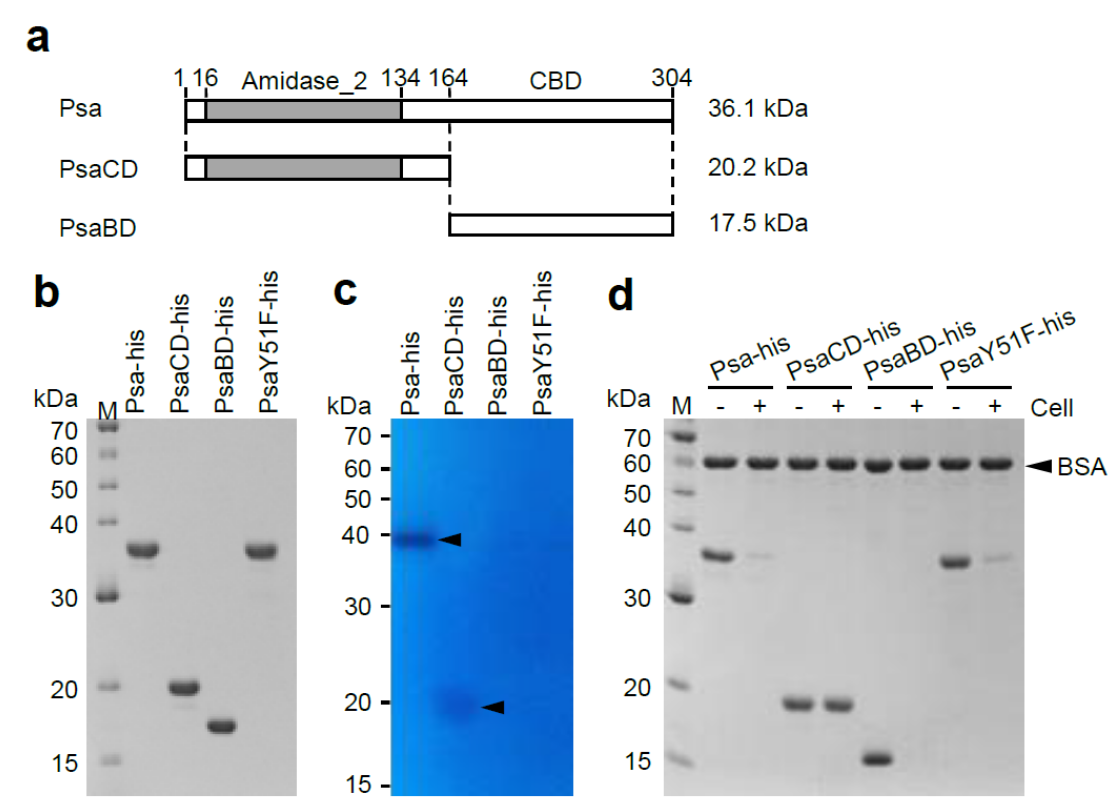
Figure 2. SDS-PAGE analysis, zymography analysis, and binding analysis of Psa-his, PsaCD-his, PsaBD-his, and PsaY51F- his. ( a ) Schematic diagrams of Psa, PsaCD, and PsaBD are shown Psa has an N-terminal catalytic domain (CD) of the amidase_2 family (indicated by gray bar) and a novel C-terminal cell wall-binding domain (CBD). These proteins were expressed and purified with a histidine-tag (MNHKVHHHHHH) fused to the N-terminus. The molecular weights of each histidine-tagged protein are shown on the right of the corresponding horizontal bar. ( b ) Purified Psa-his, PsaCD-his, PsaBD- his, and PsaY51F-his (1 µ g each) were subjected to 12.5% SDS-polyacrylamide gel electrophoresis. The gel was stained with Coomassie blue R. ( c ) Zymography analysis was carried out according to the Materials and Methods. Purified Psa-his (0.5 µ g), PsaCD-his (2.0 µ g), PsaBD-his(2.0 µ g), and PsaY51F-his (0.5 µ g) were electrophoresed in a 12.5% SDS-polyacrylamide gel containing 20 OD 600 of heat-inactivated and SDS-treated C. perfringens HN1314 cells. The arrowheads indicate cell lysis. ( d ) Binding activity was measured according to the Materials and Methods. The purified protein and non-binding internal standard, bovine serum albumin (BSA), were combined with (+) or without ( − ) C. perfringens HN1314 cells; the mixtures then were centrifuged, and the resulting supernatants were analyzed by 12.5%